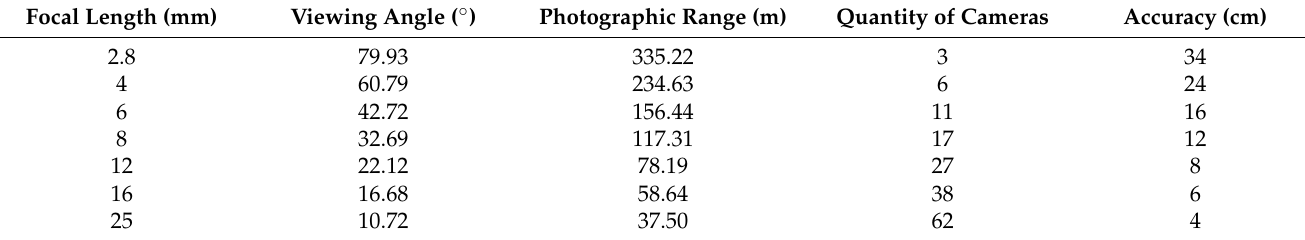
Table 2. Quantity of cameras and accuracy calculated by different focal lengths and view